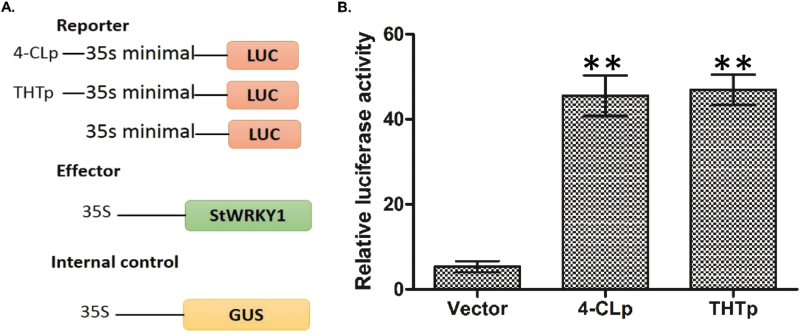
Transcriptional regulation of HCAA biosynthetic genes by StWRKY1: (A) constructs used in the transient expression assay and (B) relative LUC reporter activity by StWRKY1. Values are averages of three replicates. Significant differences in expression levels in promoters compared with vector using Student’s t-test: *P<0.05; **P<0.01.